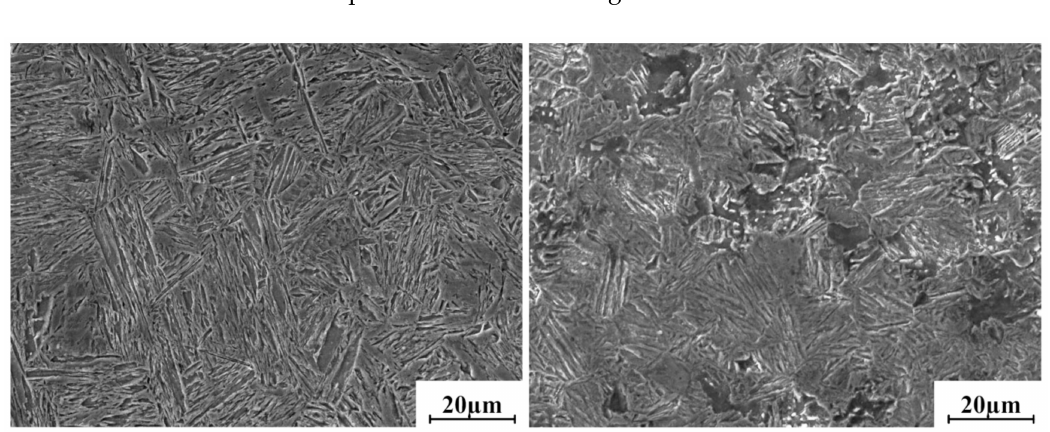
Figure 8. ( a ) Microstructures of the bottom and ( b ) sidewall region after